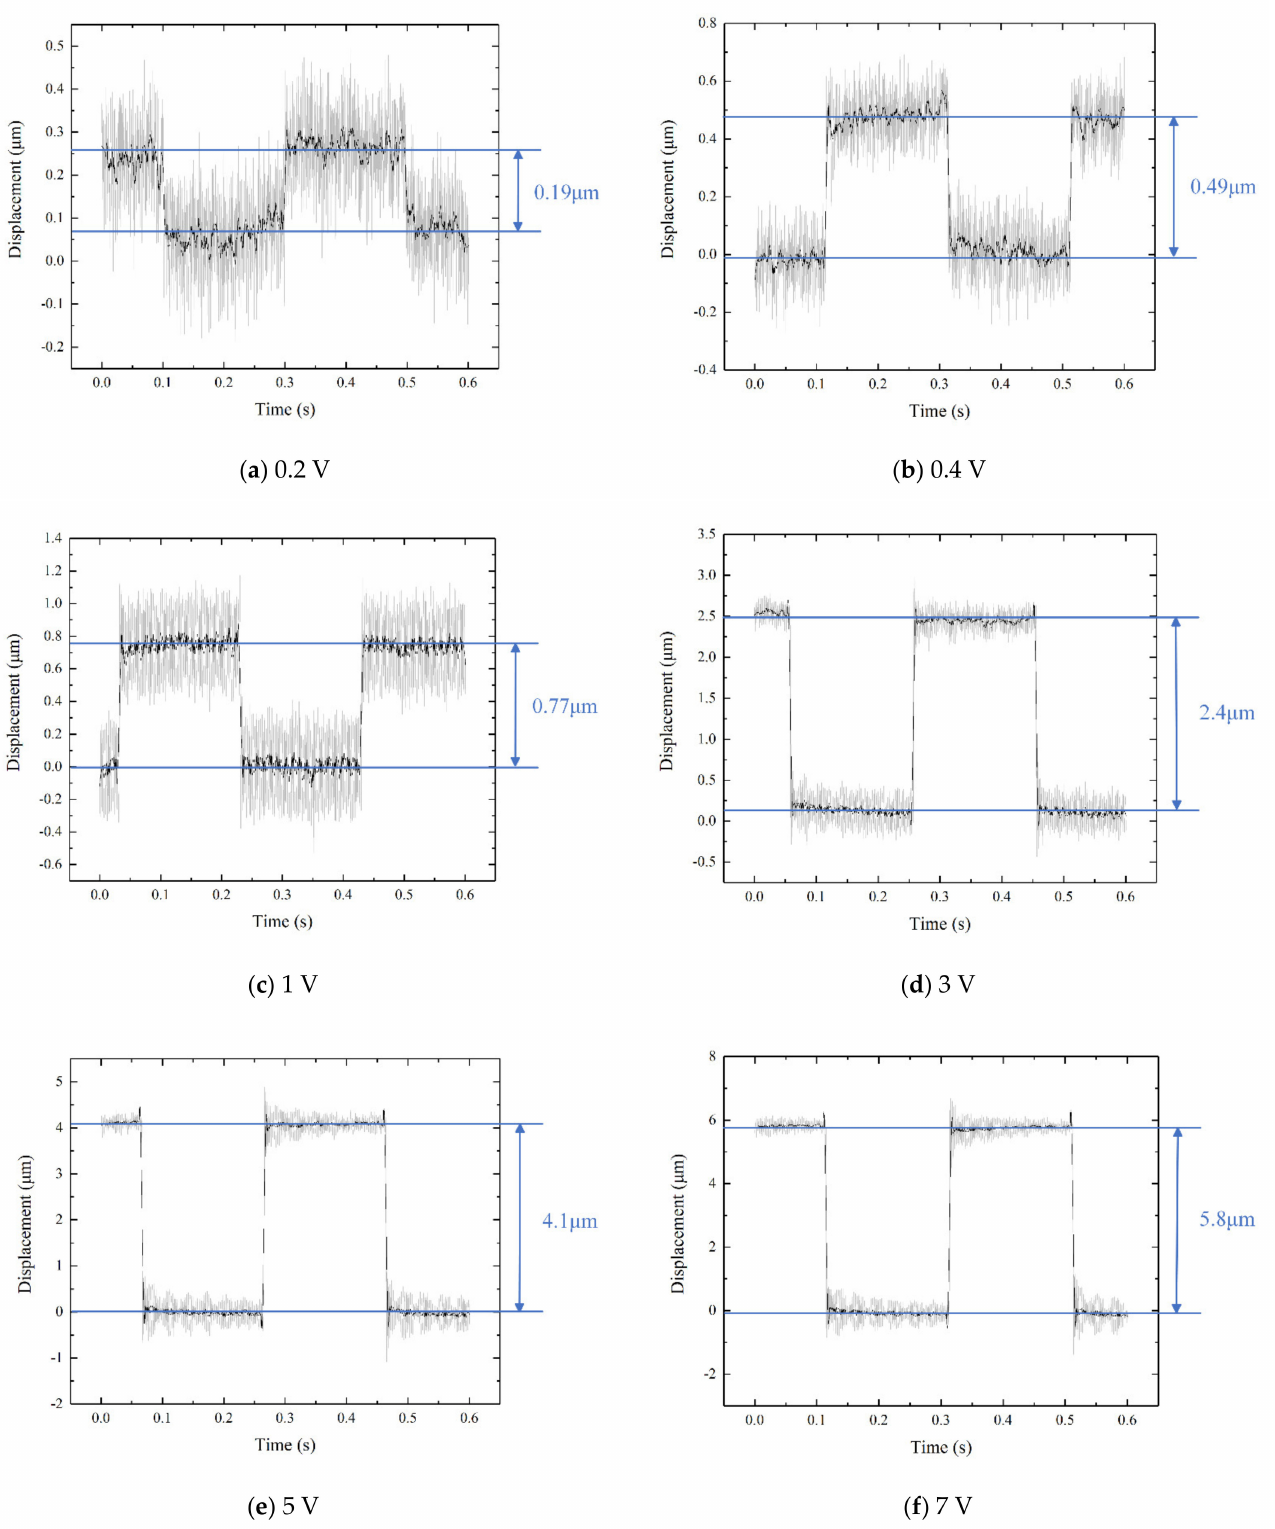
Figure 20. Displacement of the mechanism when the input voltage is ( a ) 0.2 V, ( b ) 0.4 V, ( c ) 1 V, ( d ) 3 V, ( e ) 5 V, and ( f ) 7